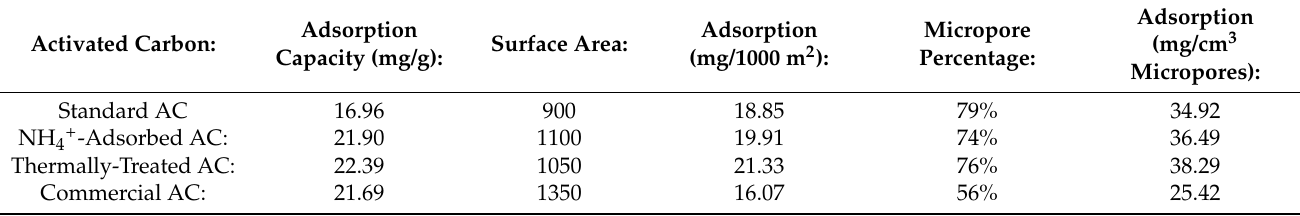
Table A1. Summary of activated carbon adsorption capacities after 2 weeks normalized to